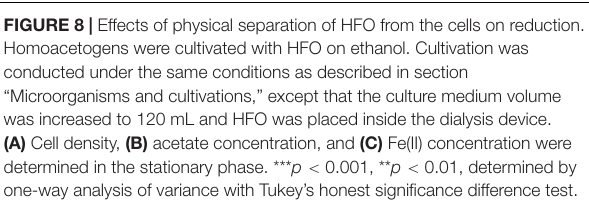
FIGURE 8 | Effects of physical separation of HFO from the cells on reduction. Homoacetogens were cultivated with HFO on ethanol. Cultivation was conducted under the same conditions as described in section “Microorganisms and cultivations,” except that the culture medium volume was increased to 120 mL and HFO was placed inside the dialysis device. (A) Cell density, (B) acetate concentration, and (C) Fe(II) concentration were determined in the stationary phase. *** p < 0.001, ** p < 0.01, determined by one-way analysis of variance with Tukey’s honest significance difference